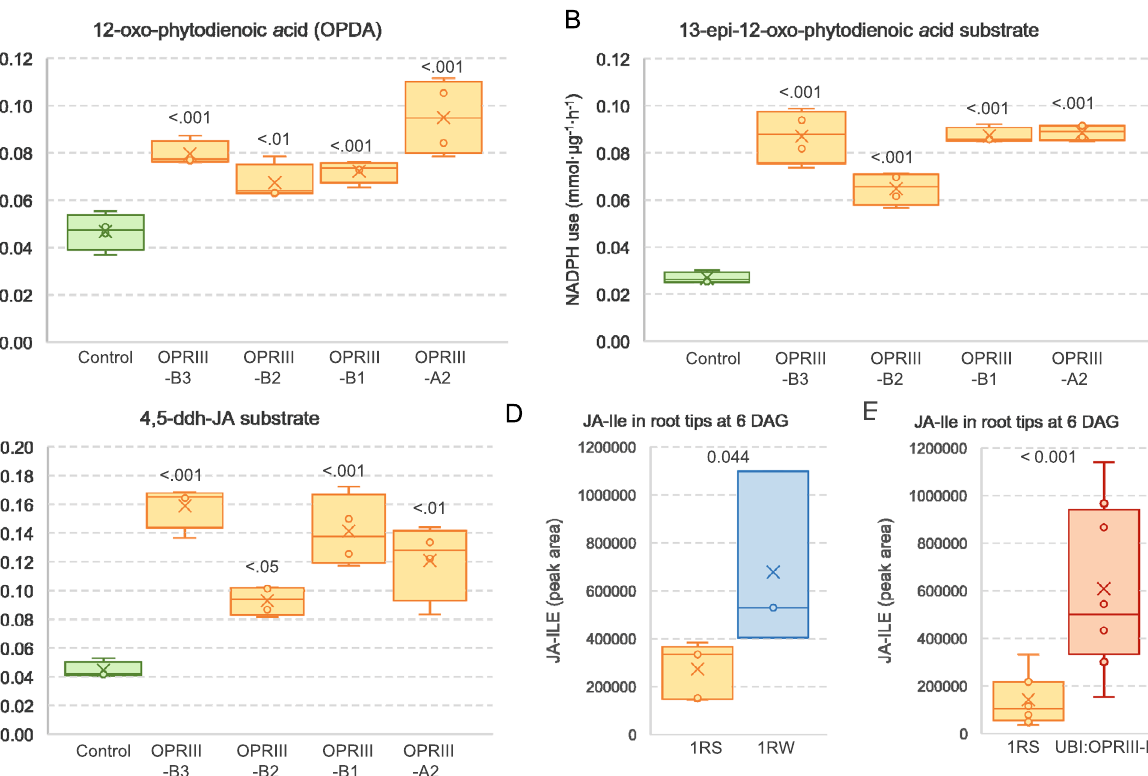
in root tips of 1RS ( n =8) and UBI::OPRIII-R5 ( n =8) at 6 DAG. P values based on ANOVA. The boxes show the range from fi rst to third quartiles divided by the median. The whiskers span from the minimum to the maximum observation and circles indicate individual data. All statistical tests are two-sided. A – E Source Data are provided as a Source Data fi